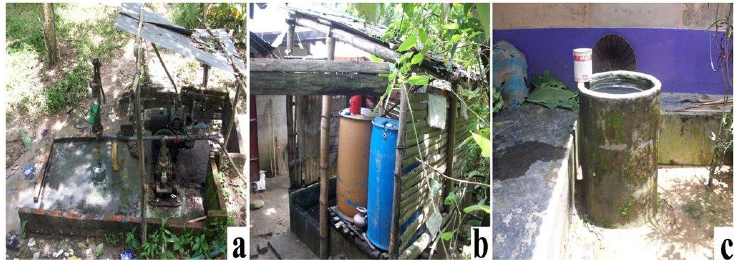
Figure 4. ( a ) Setting water pump; storing water in ( b ) plastic drum and ( c ) cemented